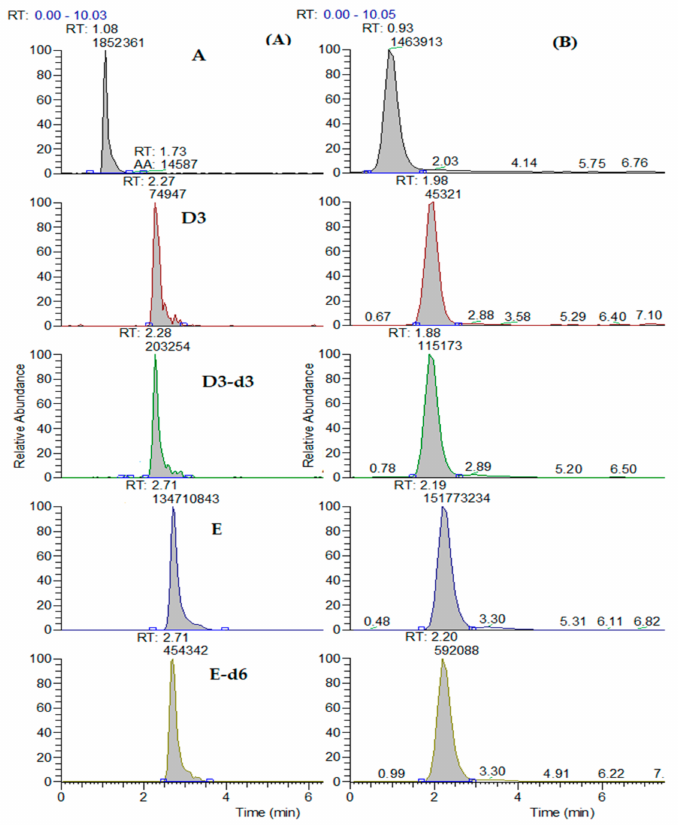
Figure 2. Comparative chromatogram of a mix standard solution through LC-APCI-MS/MS (at- mospheric pressure chemical ionization and tandem mass spectrometric methods) with columns ( A ) Atlantis T3 and ( B ) ACQUITY UPLC BEH C18. RT: retention